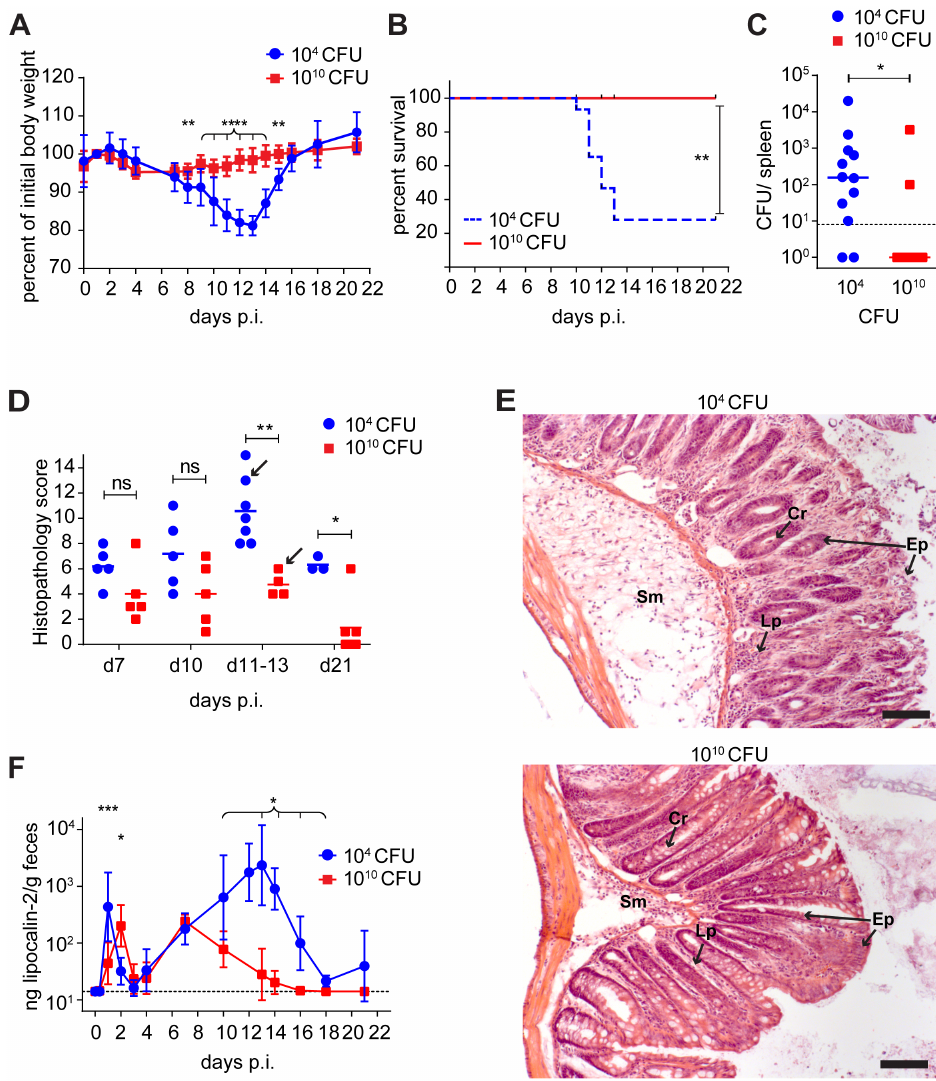
Fig 2. High-dose C . rodentium infection is associatedwith reduced severityof disease in germ-free wild-type mice. ( A ) Body weight of germ-free mice infected with either 10 4 (blue circles) or 10 10 (red squares) CFU/mouse of C . rodentium ,(n = 15 until day 10). ( B ) Survivalcurve of the animalsshown in A. ( C ) Splenic bacterial loads of mice shown in A infected with 10 4 (blue circles) or 10 10 (red squares)CFU/mouse of C . rodentium for 10–13 days; n = 10–12per group. ( D ) Histopathological scores of mice shown in panelA (Endpointcriterion: weight loss of > 20 %). Mice were scored for epithelialhyperplasia and integrity, infiltration of PMNs, submucosal edema, and loss of goblet cells. Graph shows combinedscore (= sum of 5 individual scores). ( E ) Representative images of colonichistopathology scored in panel D (H&E staining)of mice infected for 13 days with 10 4 (top) and 10 10 (bottom) CFU. Arrows in panel D indicate the individuals depicted. Scale bar: 100 μ m; Sm, submucosa; Cr, crypts; Ep, epithelium;Lp, lamina proria; ( F ) Lipocalin-2 measurement by ELISA in feces from infected mice (n = 5 per group, same animalsas shown in A; after day 13 n = 3 survivors in 10 4 group). Error bars indicate standarddeviation.Dotted lines indicate detectionlimit; ns, statistically not significant; * , p < 0.05; ** , p < 0.01; *** , p < 0.001; **** ,p < 0.0001; statistical tests: Student‘s t-test (A), Mantel-Coxtest (B), Mann-Whitney U test (C, D,